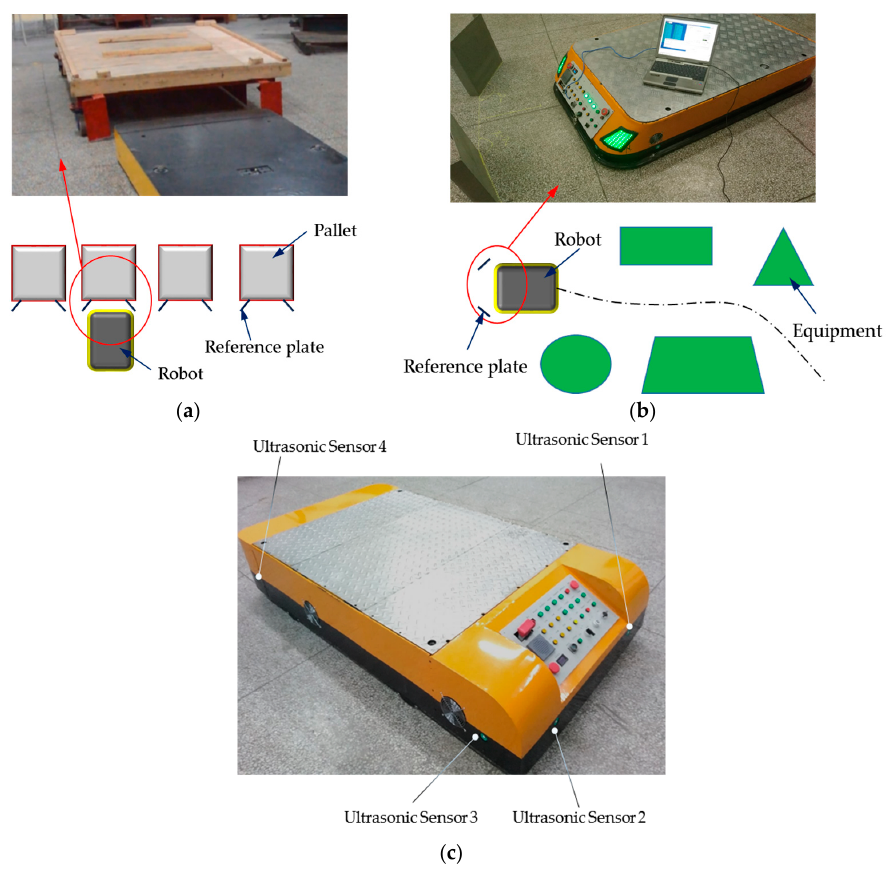
Figure 8. Applications of the omni-directional scanning localization method. ( a ) The transit tasks application; ( b ) the localization application; ( c ) the application of an omni-directional mobile.